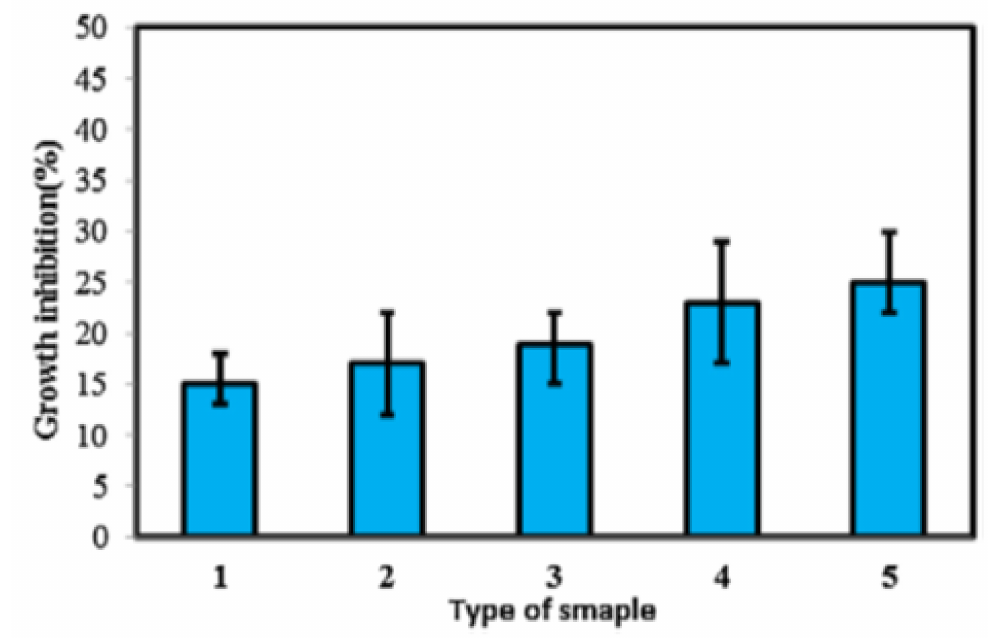
Figure 8. Cytotoxic effect of hydrogel Kappa-Carrageenan/Ag nanocomposites on the growth inhibition of VERO cells (adapted with permission from reference